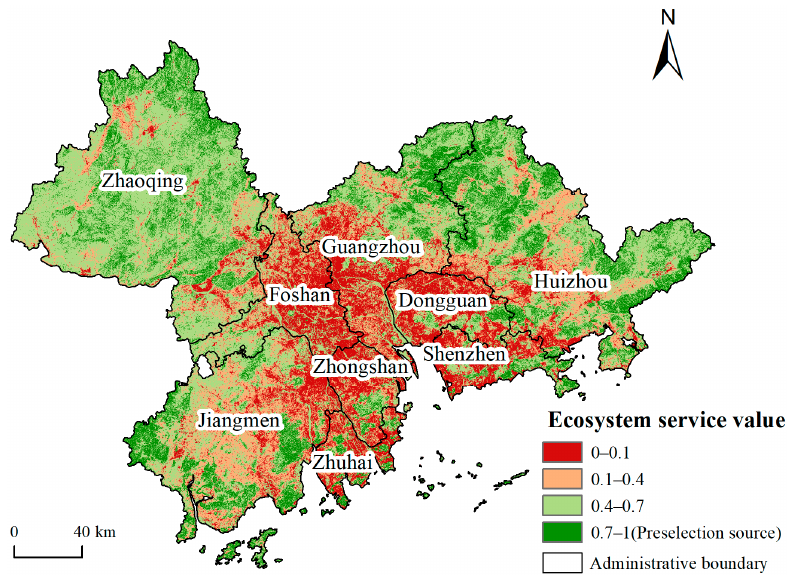
Figure 3. Spatial distribution of ecosystem service values and preselection ecological sources.